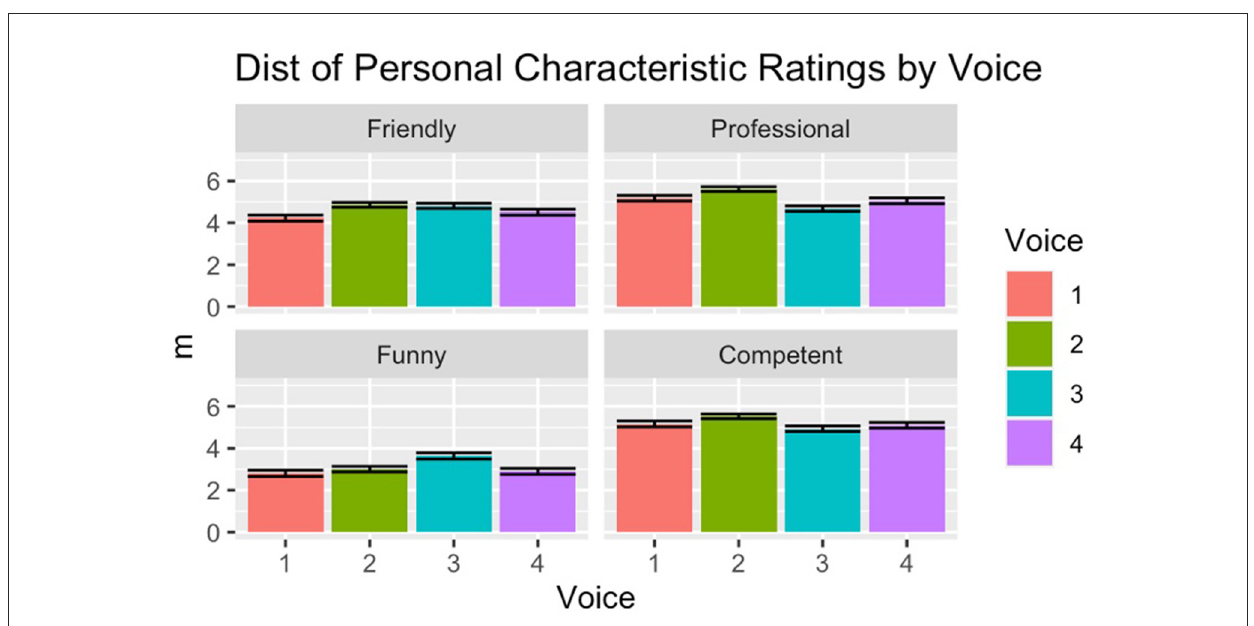
FIGURE4 Ratings for personal characteristics by